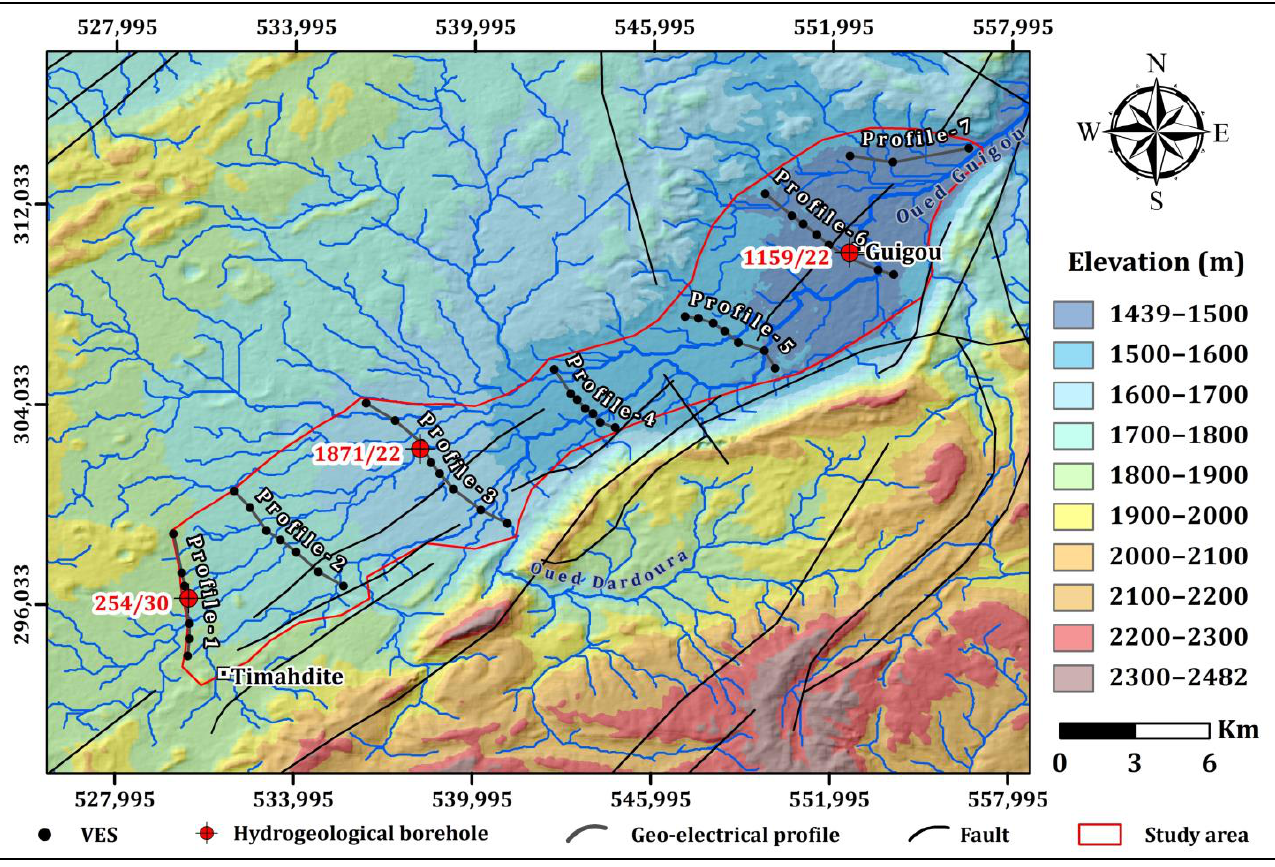
Figure 3. Position plan of VES profiles on digital terrain model.